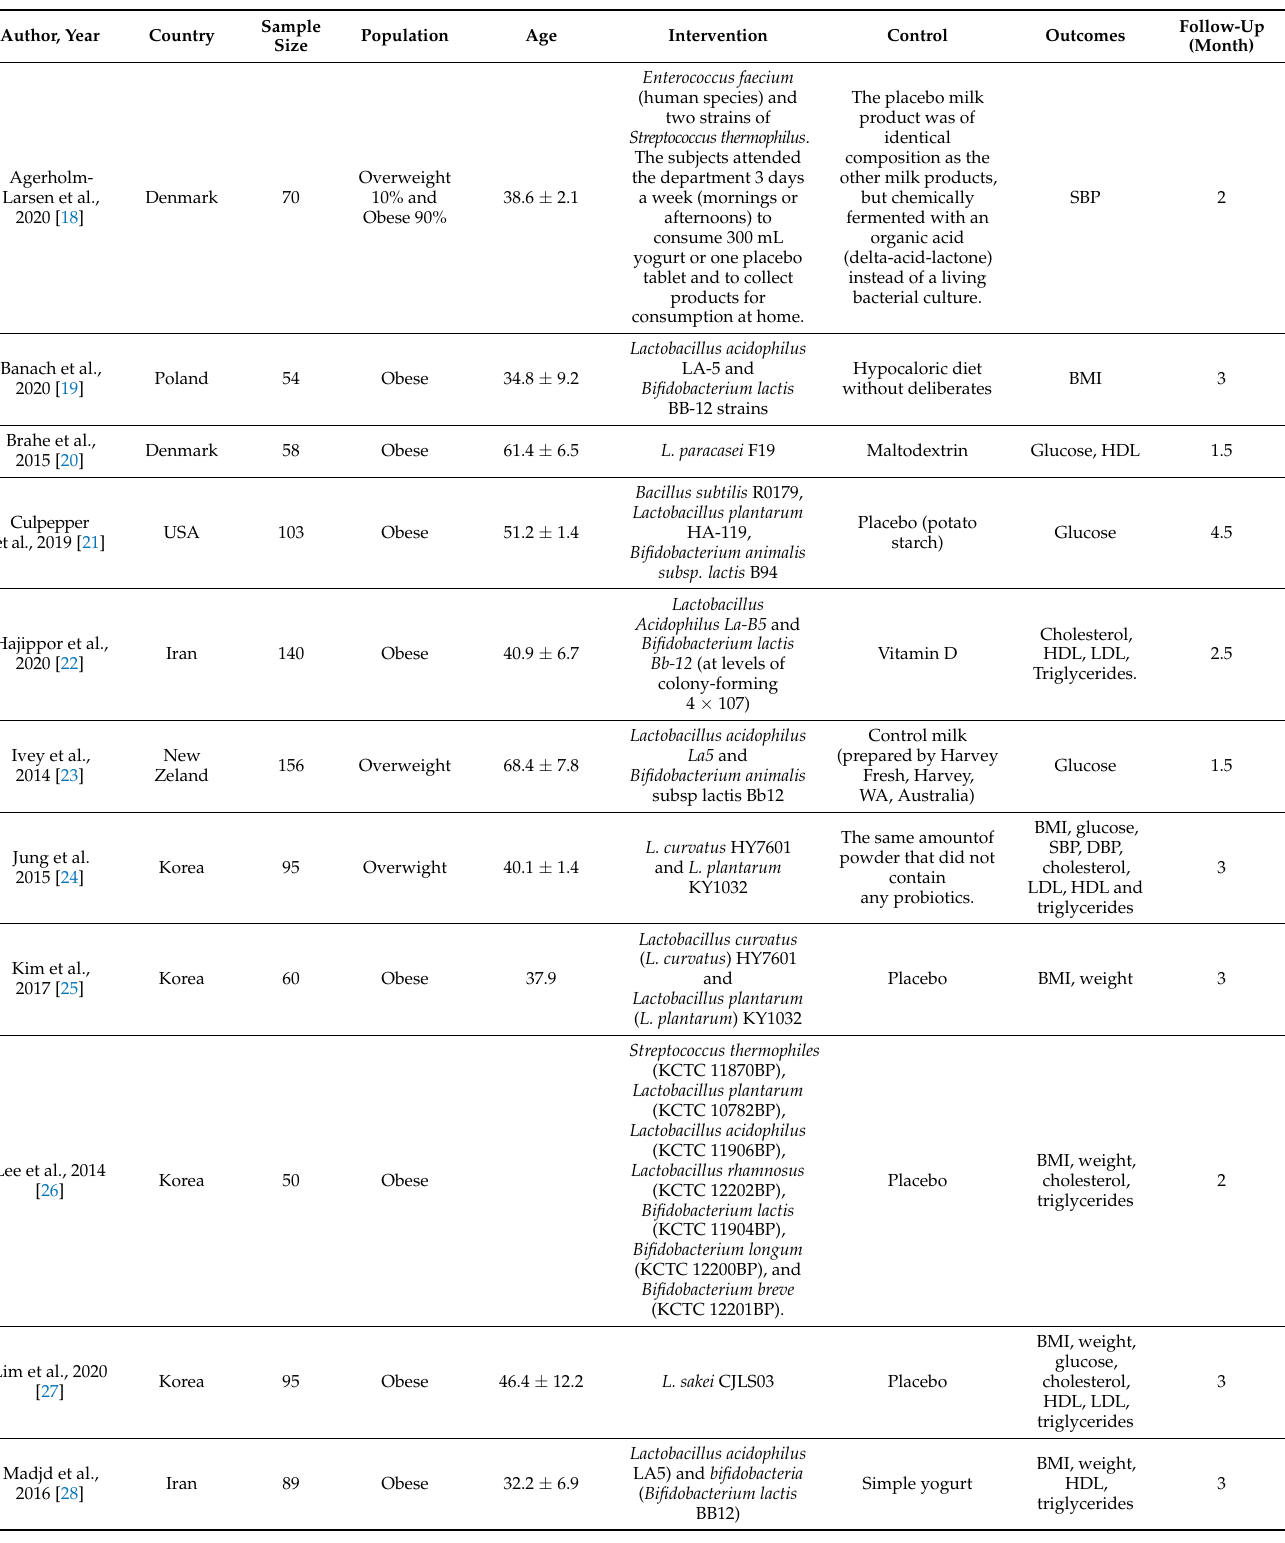
Table 1. Characteristics of included